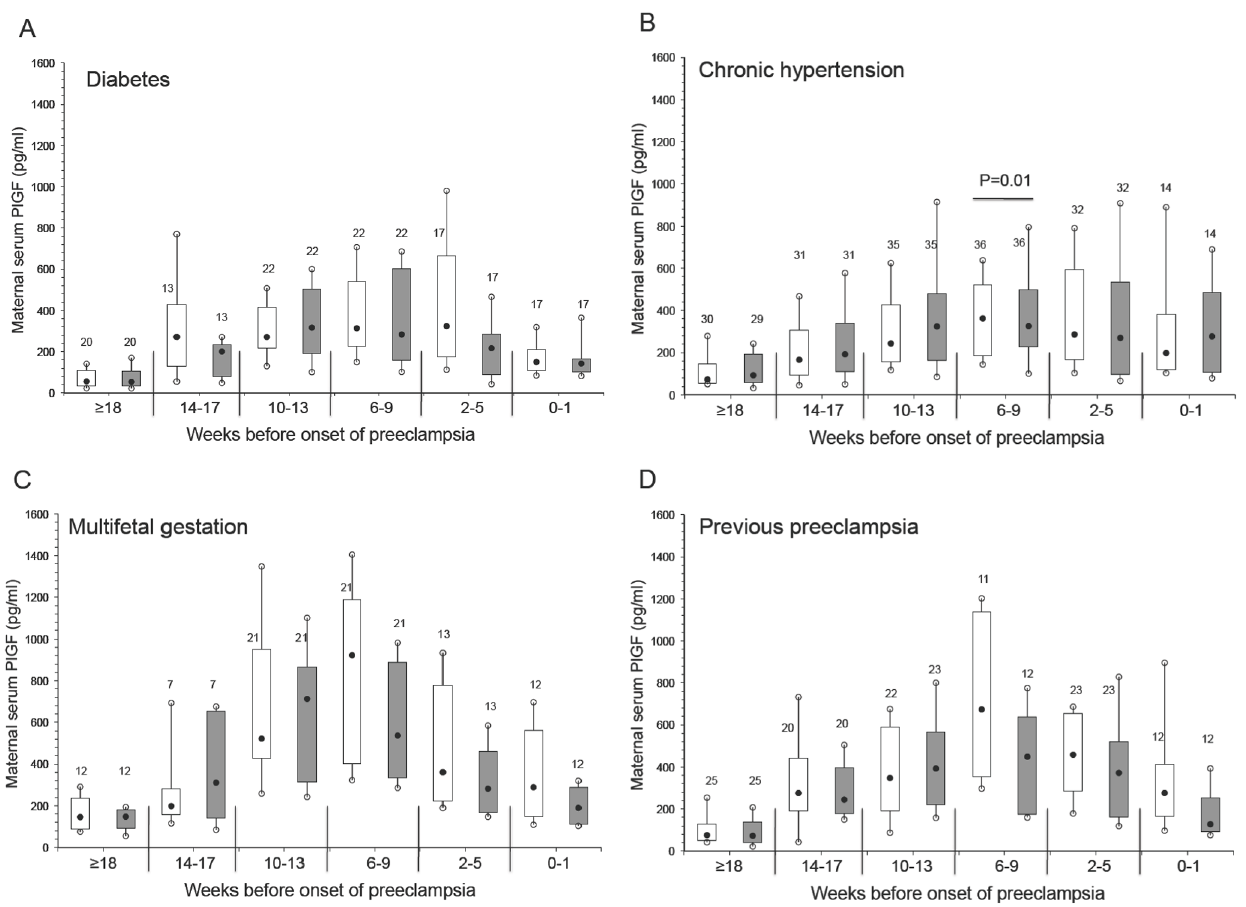
Figure 6. Maternal serum PlGF by clinical onset of preeclampsia matched to control samples in women with pre-existing diabetes (A), chronic hypertension (B), multifetal gestation (C), and previous preeclampsia (D). Open boxes are controls and shaded boxes are subjects who developed preeclampsia. The number above each box indicates the number of samples. The filled black circles are the median, the open circles are the 90th and 10th percentiles, and the top and bottom lines of the box are the 75 th and 25 th percentiles of the data for each group. Statistical significance is indicated by p values.